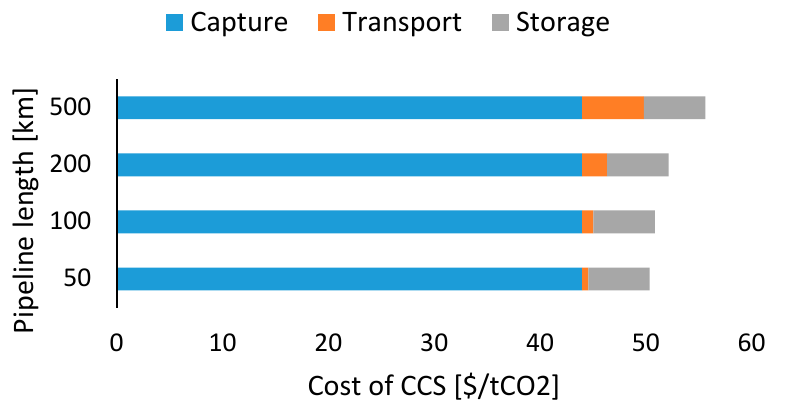
Figure 17. Total cost of CCS chain for several pipeline length, subdivided into the three components: capture, transportation, and storage in NGH. For the transportation cost was used a mean value while for the storage cost in NGH reservoir was assumed two wells.